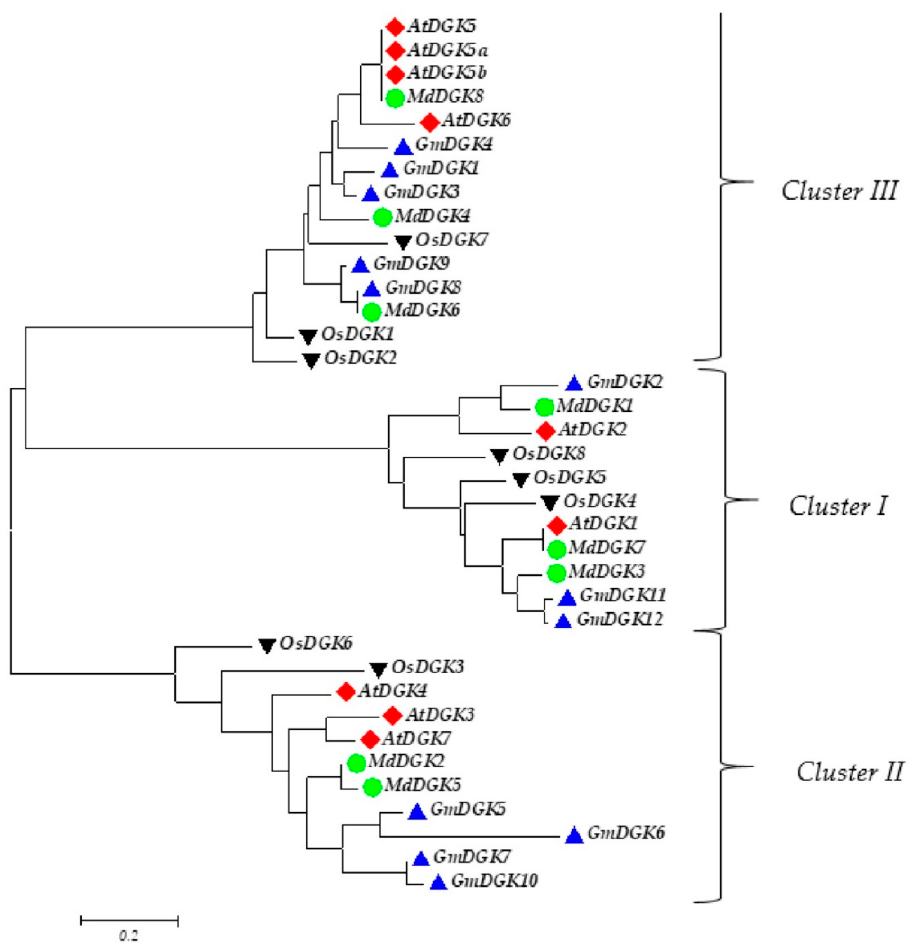
Figure 4. Phylogenetic analyses of DGK genes in soybean (Gm), Arabidopsis (At), rice (Os), and apple.